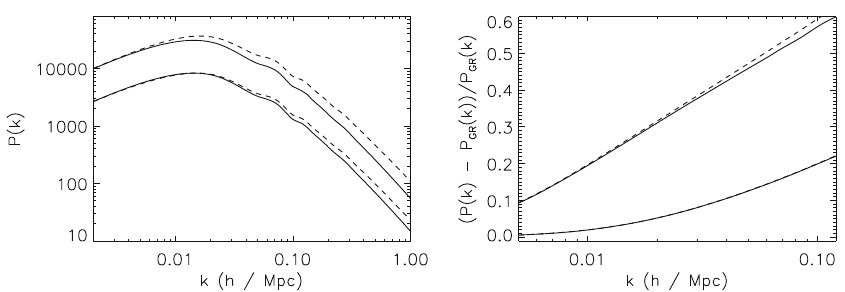
= 0, ν = 1 . 5) and scalaron Fig. 32 Left panel: Linear matter power spectra for Λ CDM (solid line; M − 1 0 − 1 = 375 [ 10 28 h − 1 eV − 1 ] , ν = 1 . 5) cosmologies. The modification to gravity causes a (dashed line; M 0 sizeable scale dependent effect in the growth of perturbations. The redshift dependence of the scalaron can be seen by comparing the top and bottom pairs of power spectra evaluated at redshifts z = 0 . 0 and z = 1 . 5, respectively. Right panel: The environmental dependent chameleon mechanism can be seen in the mildly nonlinear regime. We exhibit the fractional difference ( P ( k ) − P GR ( k ))/ P GR ( k ) between the f ( R ) and − 1 = 375 [ 10 28 h − 1 eV − 1 ] and ν = 1 . 5. The GR power spectra for the model (I.8.37) with parameters M 0 dashed lines represent linear power spectra ( P ( k ) and P GR ( k ) calculated with no higher order effects) and the solid lines are the power spectra calculated to second order. We see that the nonlinearities decrease the modified gravity signal. This is a result of the chameleon mechanism. The top set of lines correspond to z = 0 and the bottom to z = 0 . 9; demonstrating that the modified gravity signal dramatically decreases for larger z . This is due to the scalaron mass being much larger at higher redshifts. Furthermore, nonlinear effects are less significant for increasing z